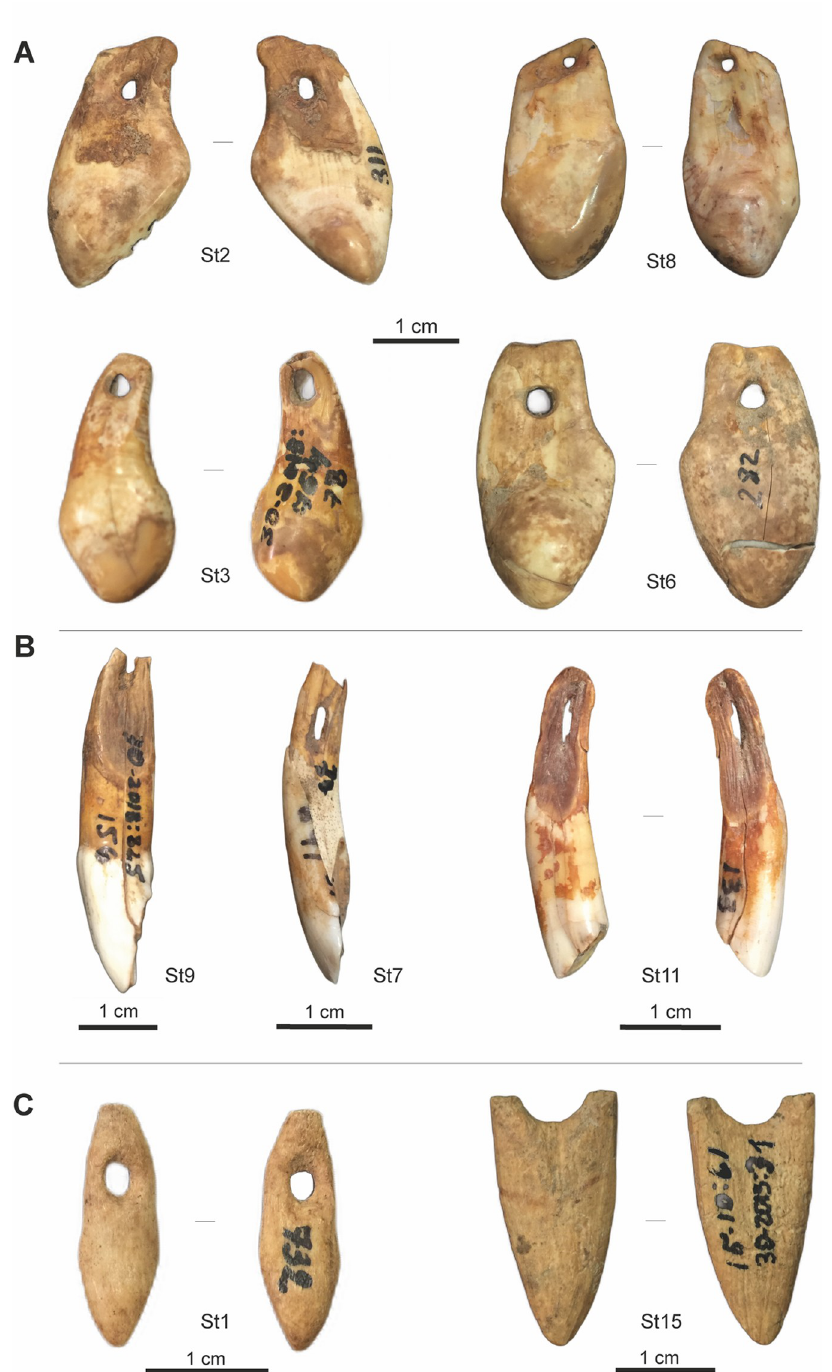
Fig 5. Pendants from Satsurblia cave. Red deer vestigial canines (A); ungulate incisors (B); bone pendants (C). Photos by J.-M. Tejero.